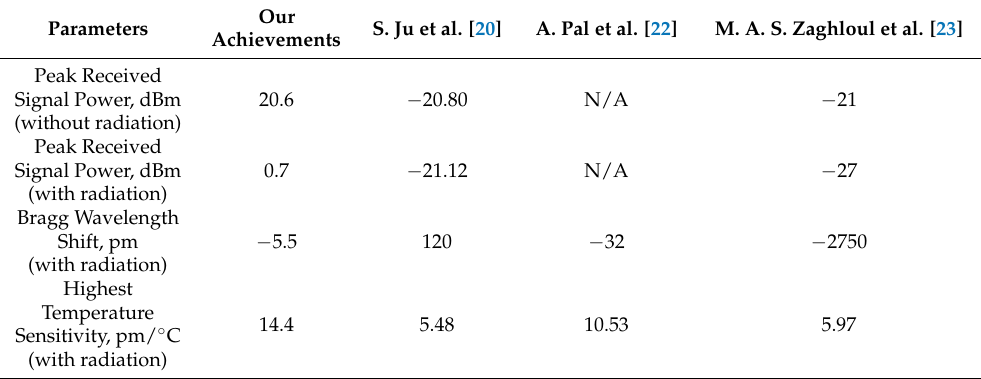
Table 1. Comparison of our experimental results with other reported research